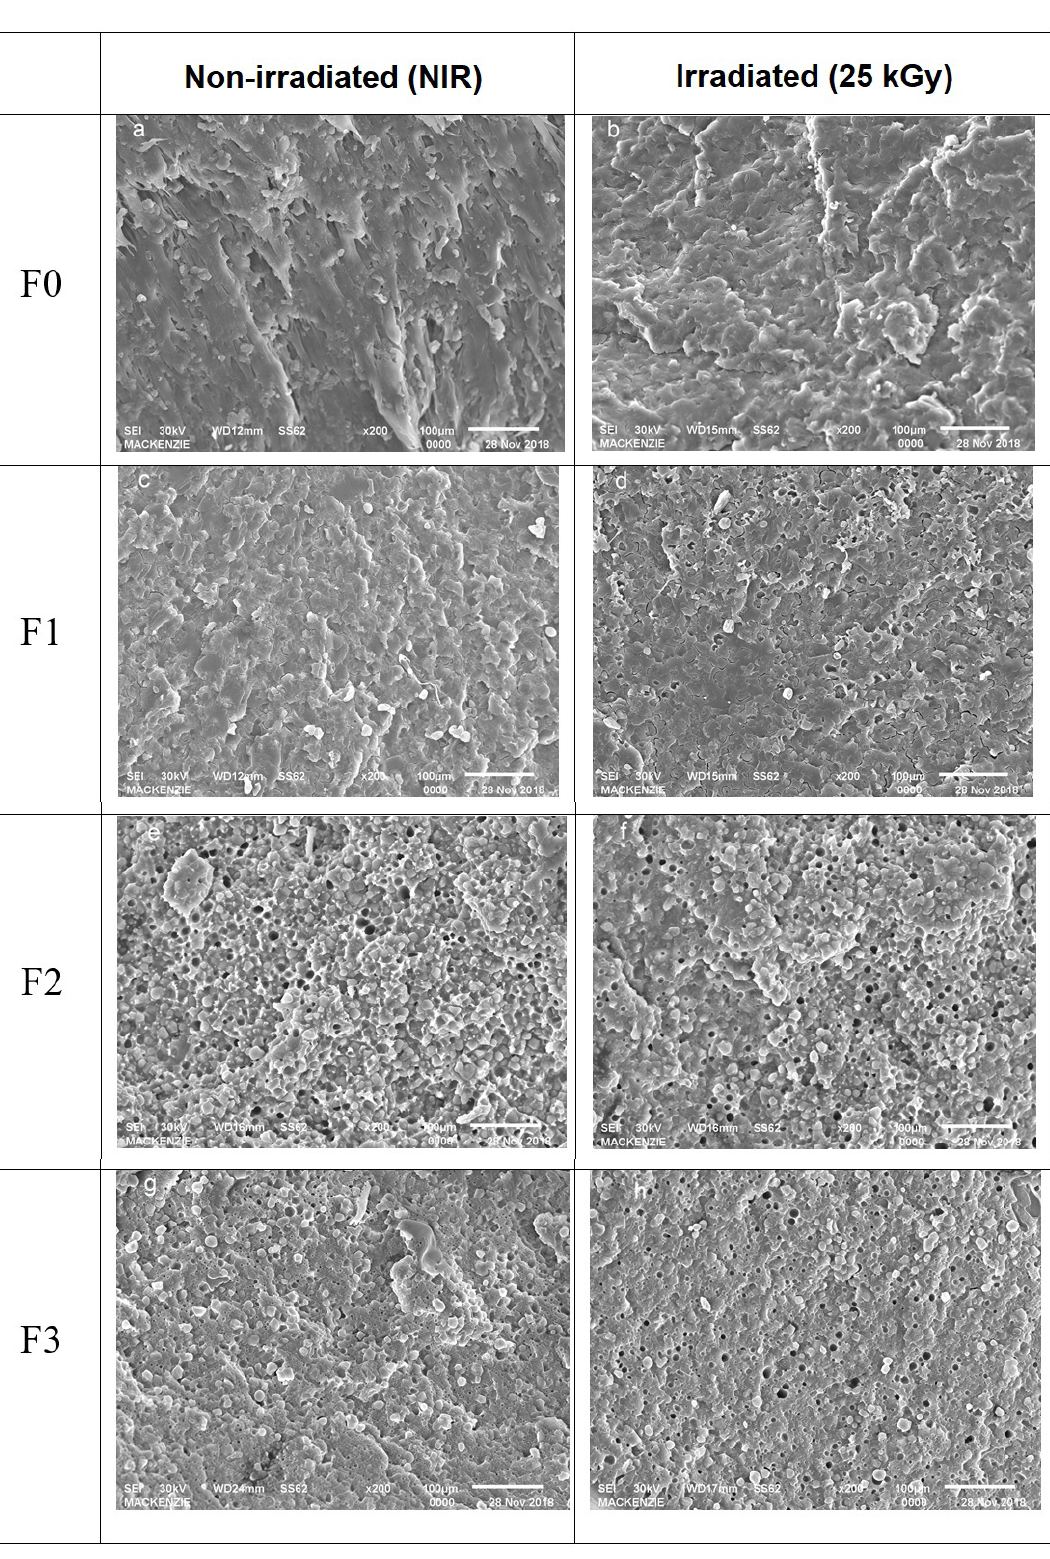
Figure 8. Micrographs of NIR and irradiated blends at 200x